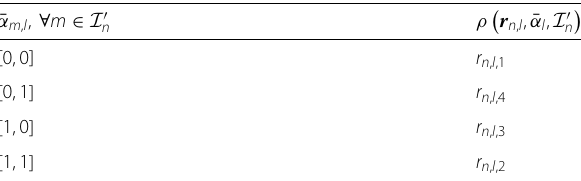
Table 2 Lookup table function ρ